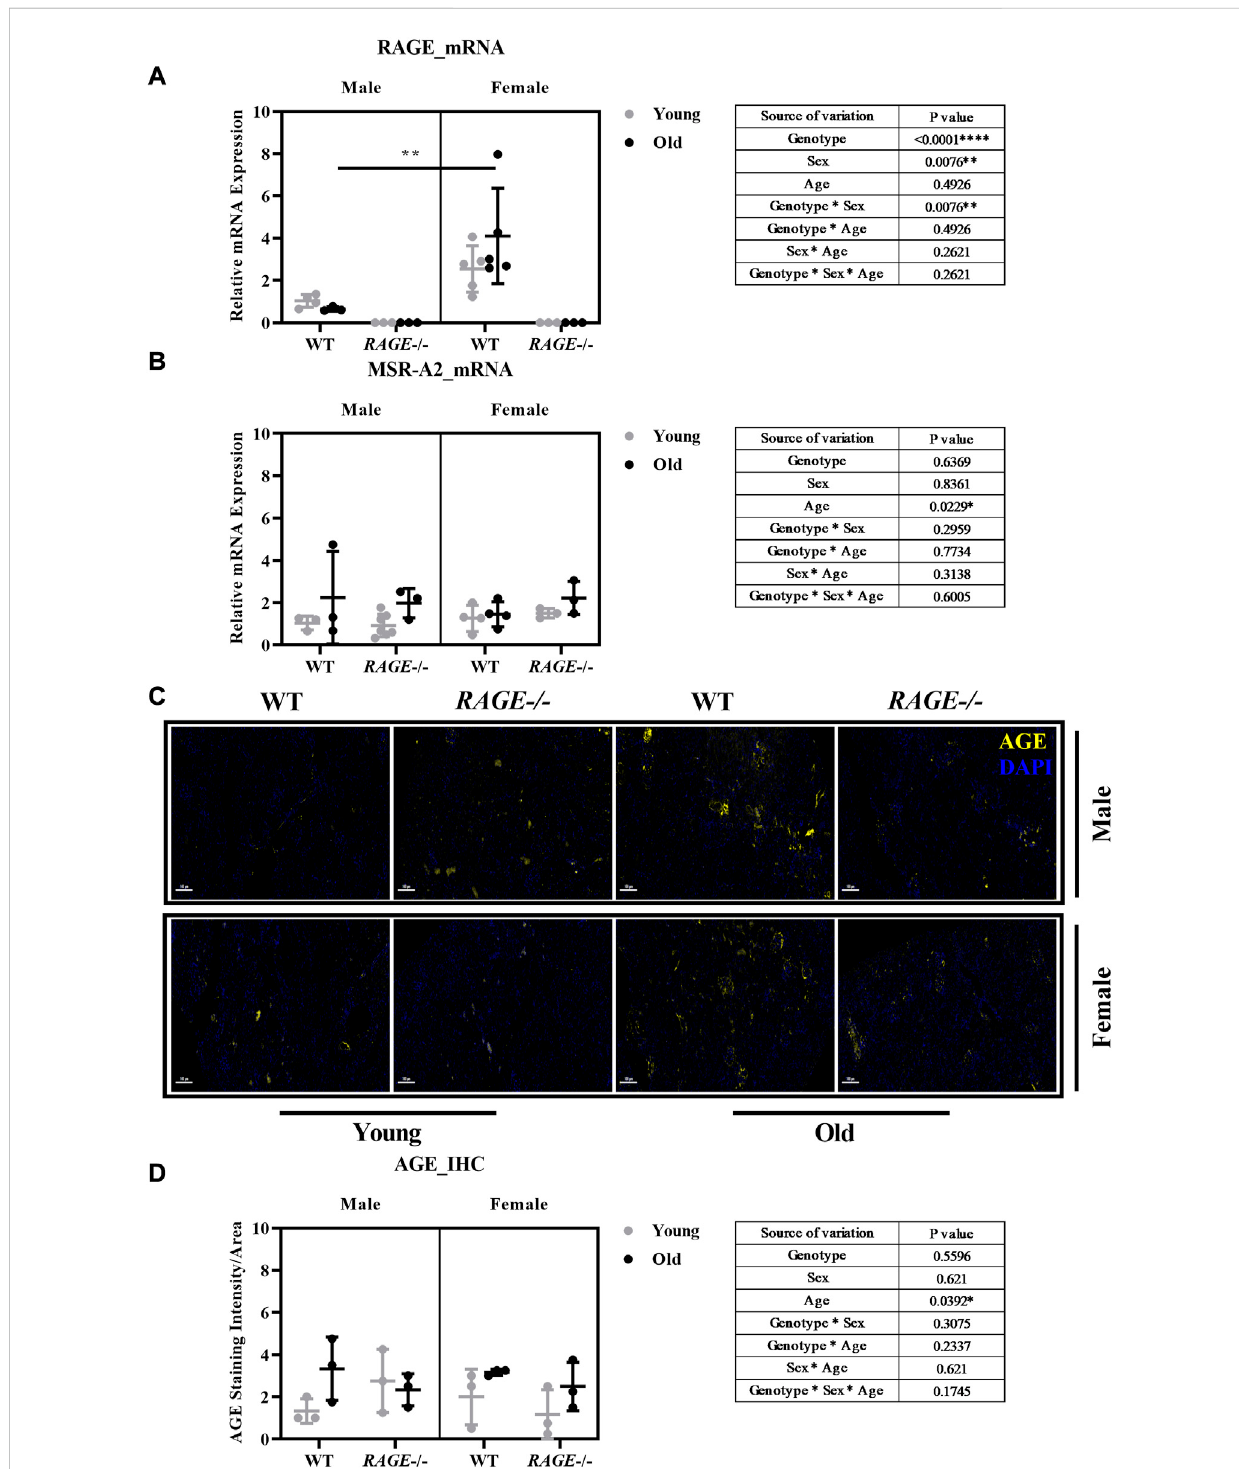
FIGURE 1 Characterization of AGE receptors and ligands in the kidneys: mRNA quanti fi cation by q-PCR for (A) RAGE and (B) MSR-A2 in the kidney cortex. (C) Representative images of AGE staining in the kidney sections in both male and female from the indicated genotypes; yellow indicates protein expressed around the glomerular and tubular region. (D) Quanti fi cation of AGE staining intensity. Signi fi cance and interaction are calculated by three-way ANOVA withgenotype(wildtype vs .RAGE − / − ,sex(male vs. female),andage(young vs. old)asthreefactors(shownintableinsert).Sidakmultiplecomparisons testswereperformedforintergroupsigni fi cance (shownabovebars).Young( < 30 weeks)andold( > 70 weeks)male andfemalemice( n =3 – 7)wereused in the experiment. Data are shown as mean ± SD; p- value: 0.05*, 0.01**, 0.001***, and